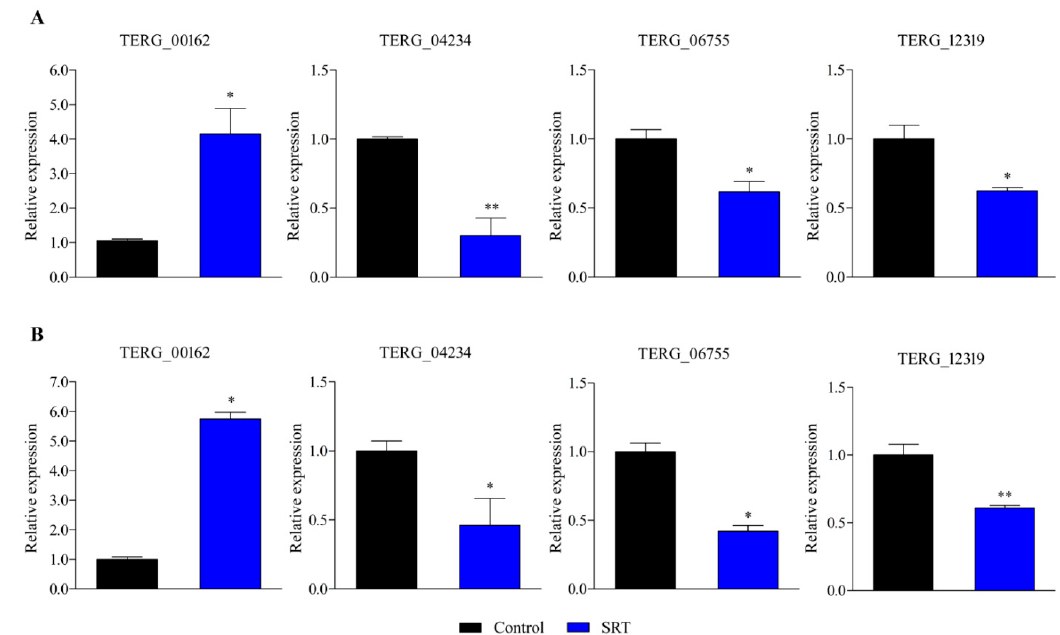
Figure 1. Differentially expressed genes in response to SRT, identified using RT-qPCR analysis. The relative expression of genes TERG_00162 (MFS multidrug transporter), TERG_04234 (Hydrophobin), TERG_06755 (C-8 sterol isomerase), and TERG_12319 (Chitin synthase 2) at 3 h ( A ) and 12 h ( B ) are represented. Asterisks indicate the statistical significance of the t -test compared to the control (SB drug absence). * p < 0.05; and ** p < 0.01.